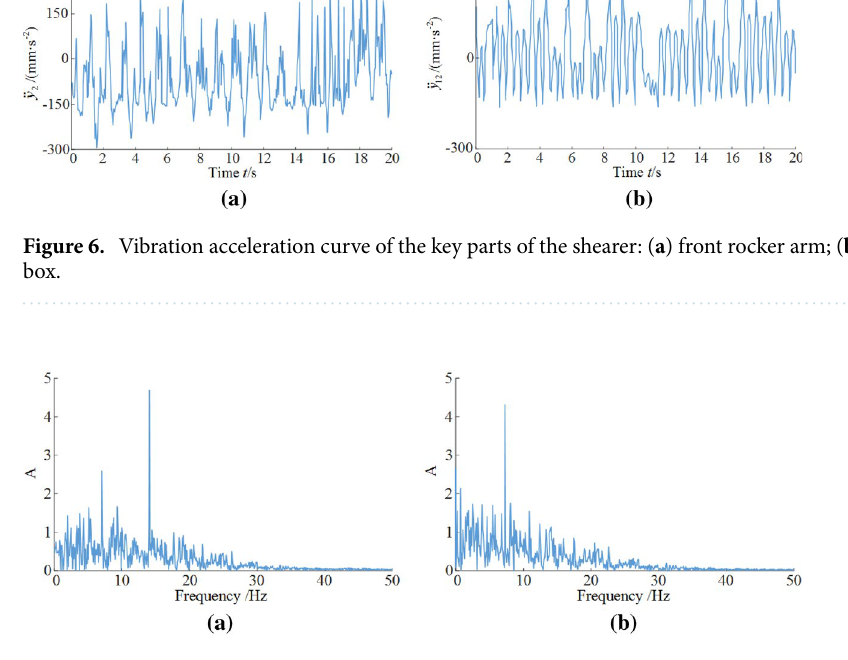
Figure 7. Vibration frequency spectra of the key parts of the shearer of ( a ) front rocker arm and ( b ) front walking